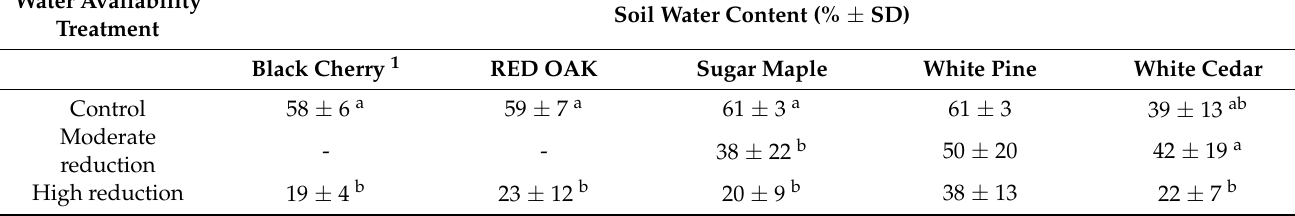
Table 1. Soil water content (mean ± sd % of pot capacity) under two or three water reduction levels (control, moderate reduction and high reduction) of black cherry ( Prunus serotina Ehrh.), northern red oak ( Quercus rubra L.), sugar maple ( Acer saccharum Marsh.), white pine ( Pinus strobus L.) and northern white cedar ( Thuja occidentalis L.) seedlings at the end of a ten week greenhouse experiment ( n = 5/water availability treatment/species). We measured the soil water content by sampling soil from random seedling pots and calculating percentage ((wet mass − dry mass)/wet mass × 100). We used one linear mixed model per species (blocks as random effect) to evaluate differences among treatment levels at the end of the experiment, using least-means differences for fixed effects when there was three level of treatment. Letters indicate statistically significant differences within a species ( α =